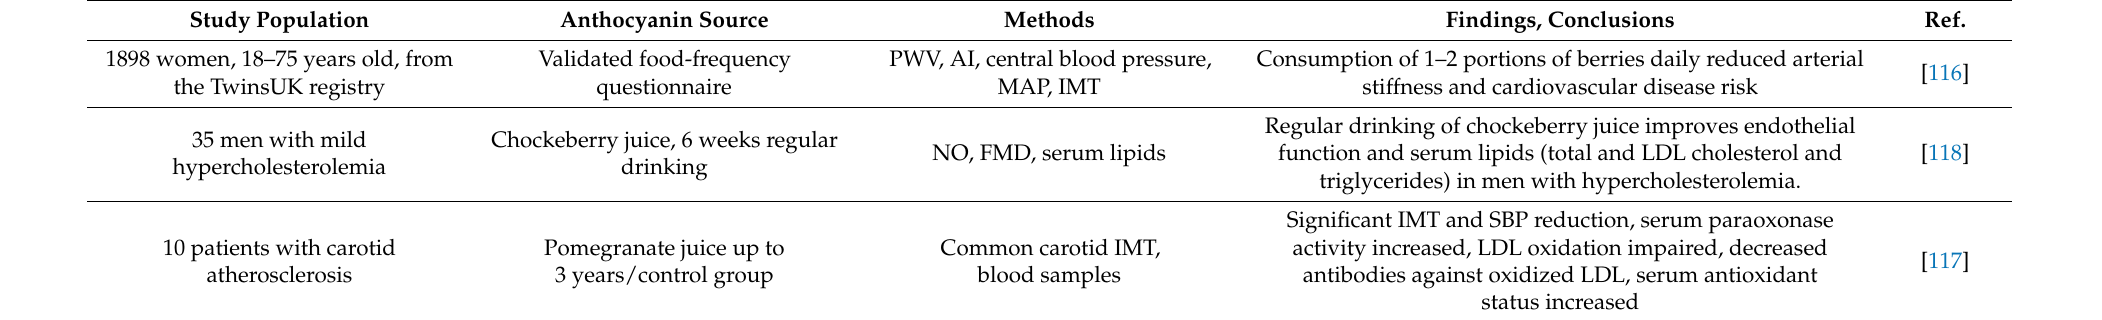
Table 3. Vascular effects of anthocyanins. Observational and intervention studies.